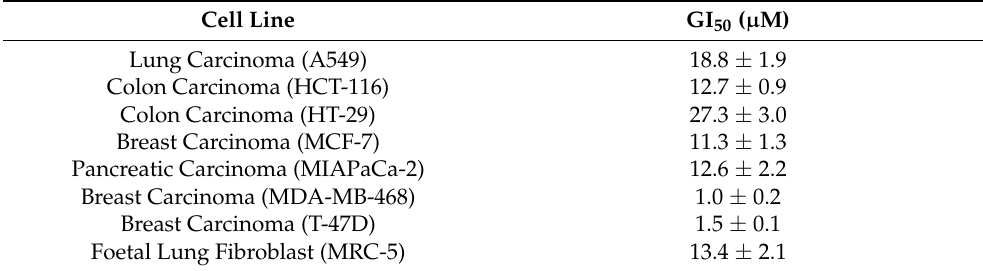
Table 1. TQ’s anti-proliferative effects on human carcinoma and fibroblast cell